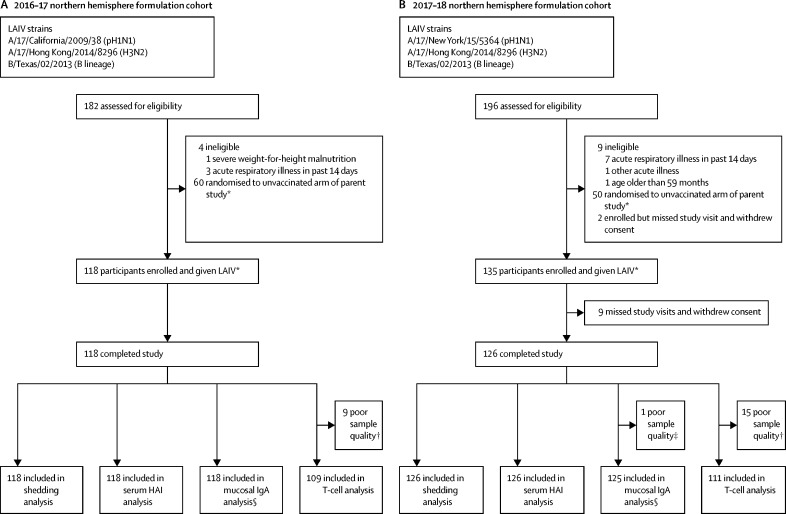
Study profileOverview of participants who received (A) the 2016–17 northern hemisphere Russian-backbone LAIV formulation and (B) the 2017–18 northern hemisphere Russian-backbone LAIV formulation. LAIV=live attenuated influenza vaccine. pH1N1=pandemic H1N1. HAI=haemagglutinin inhibition. *The study was nested within a larger randomised controlled trial (NCT02972957; appendix pp 3,4). †Sparse cell populations seen on flow cytometry. ‡Total IgA not detected in sample. §No pH1N1 data for one sample in 2016–17 cohort and no pH1N1 data for four samples and H3N2 data for three samples in 2017–18 cohort because of inadequate sample volume.